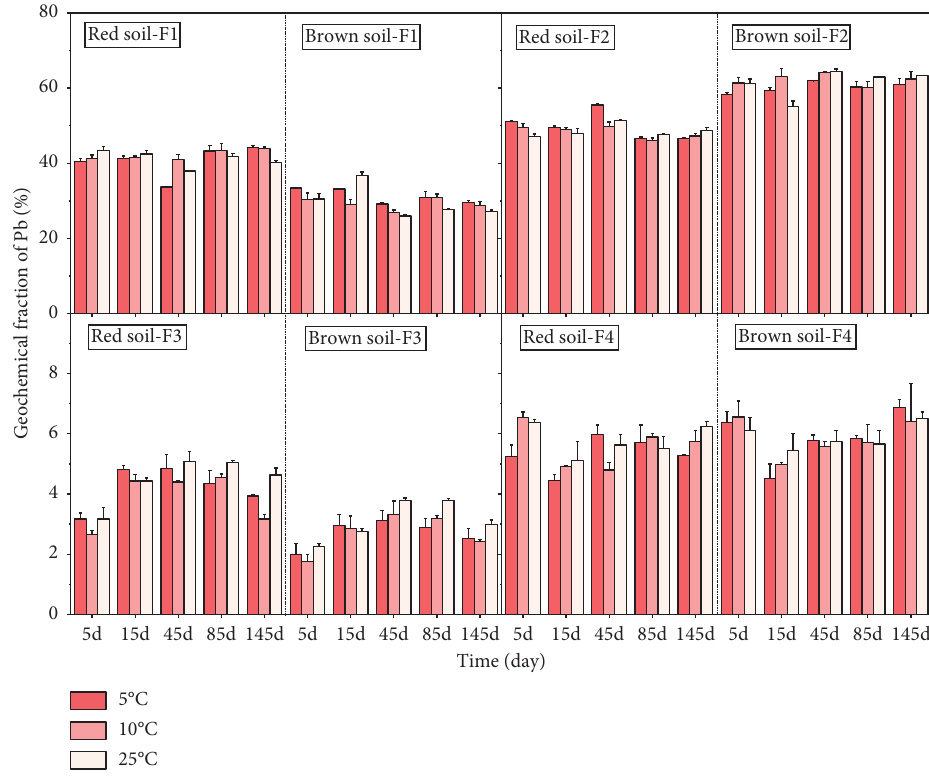
Figure 4: Changes of Pb fractions in soils at different temperatures as a function of contact time.